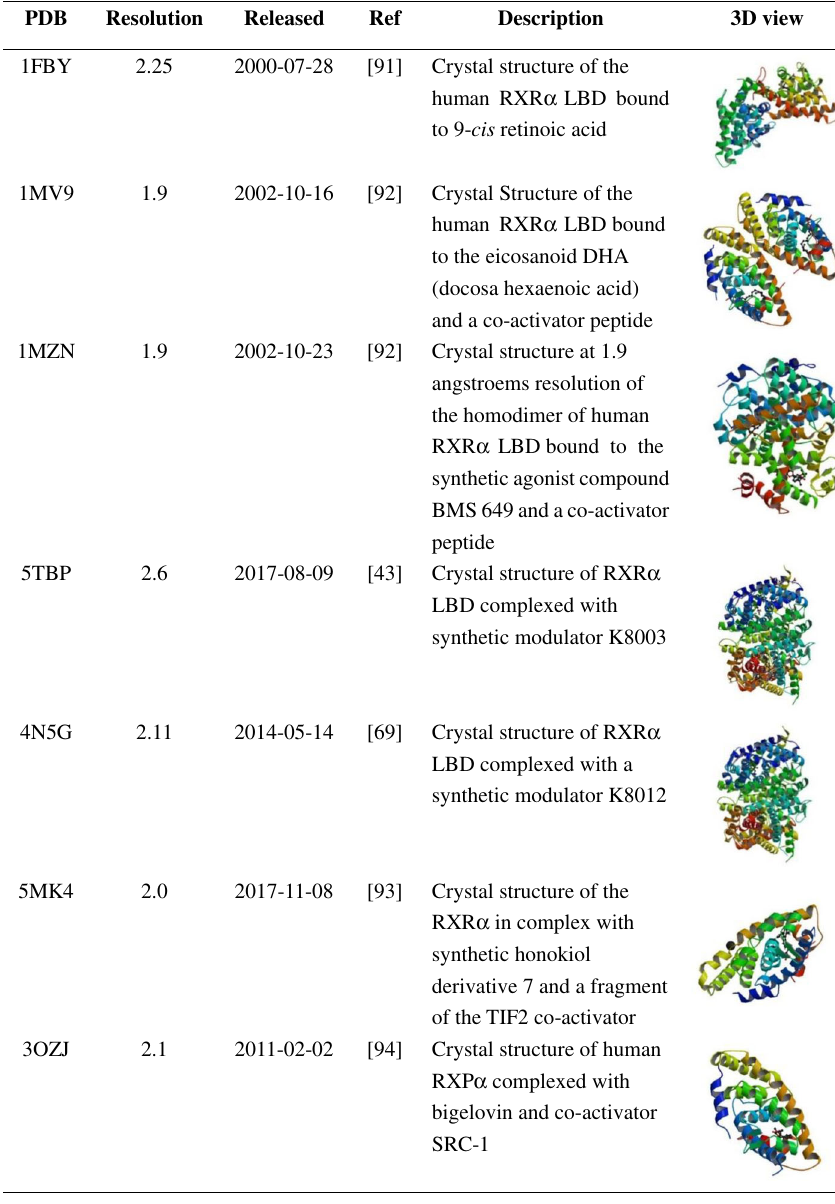
Table 3 The 3D structure of RXR α with compounds [43, 69, 91 – 94]